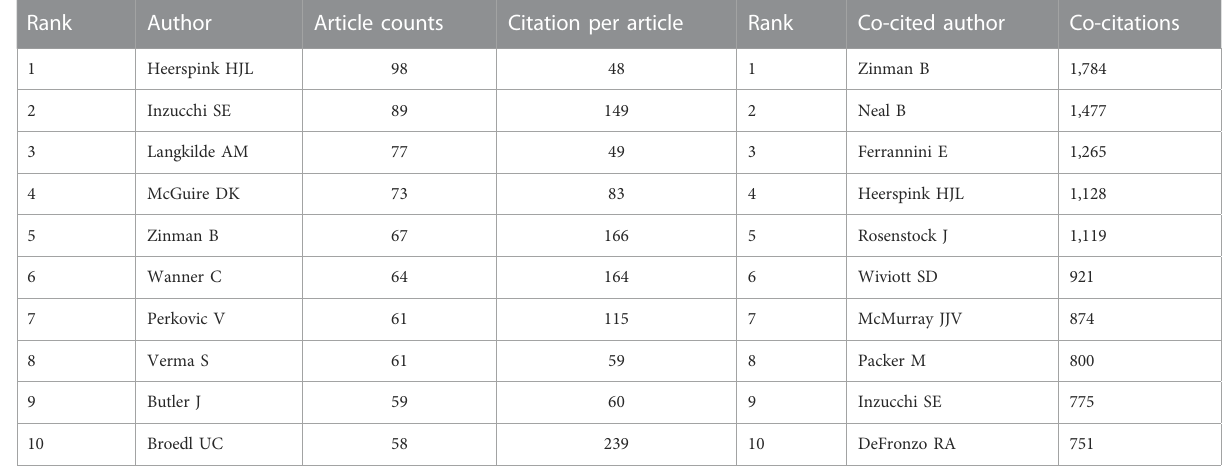
TABLE 3 Top 10 productive authors and co-cited authors in SGLT2 inhibitor